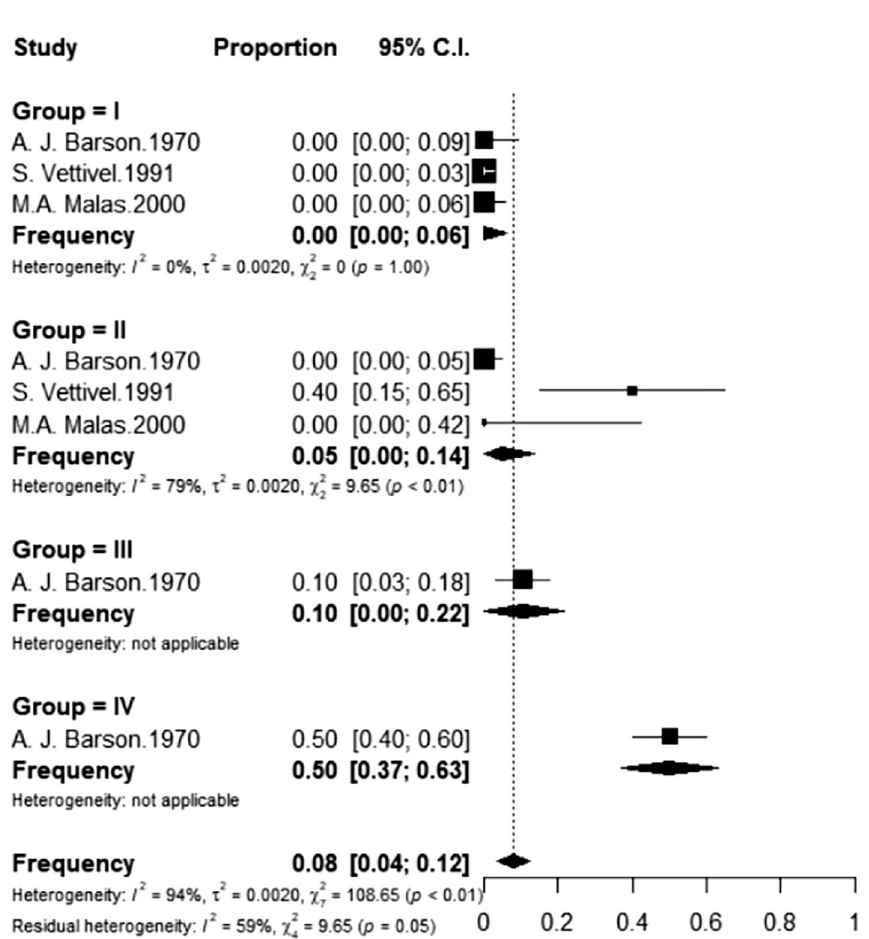
Figure 5. Frequency of foetuses evaluated post-mortem with CM at L2 or above distributed by gestational age group. Group I (13–18 weeks); II (19–25 weeks); III (26–32 weeks); IV (33 weeks to the probable date of